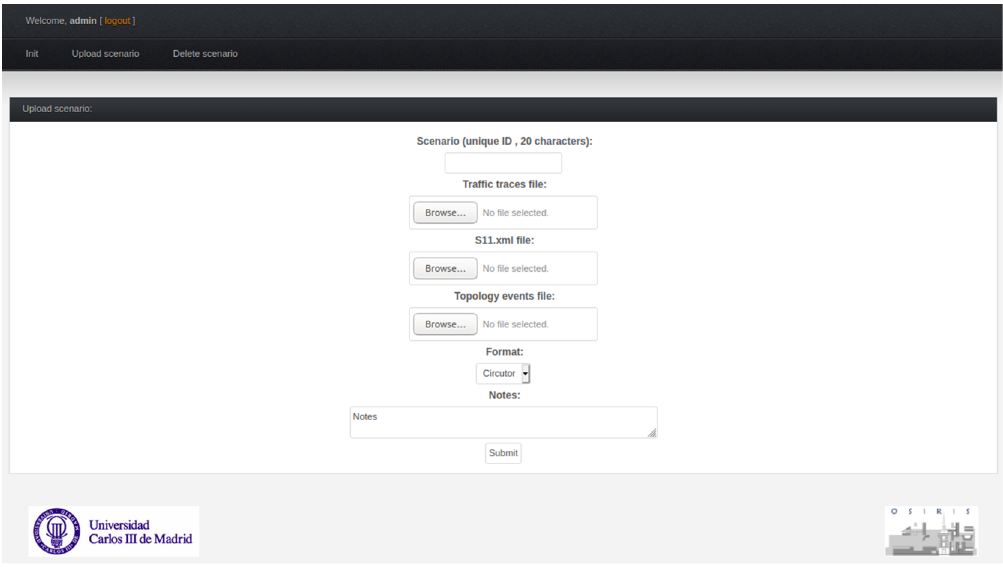
Figure 8. Web page for uploading new scenarios to PRIME Analytics.